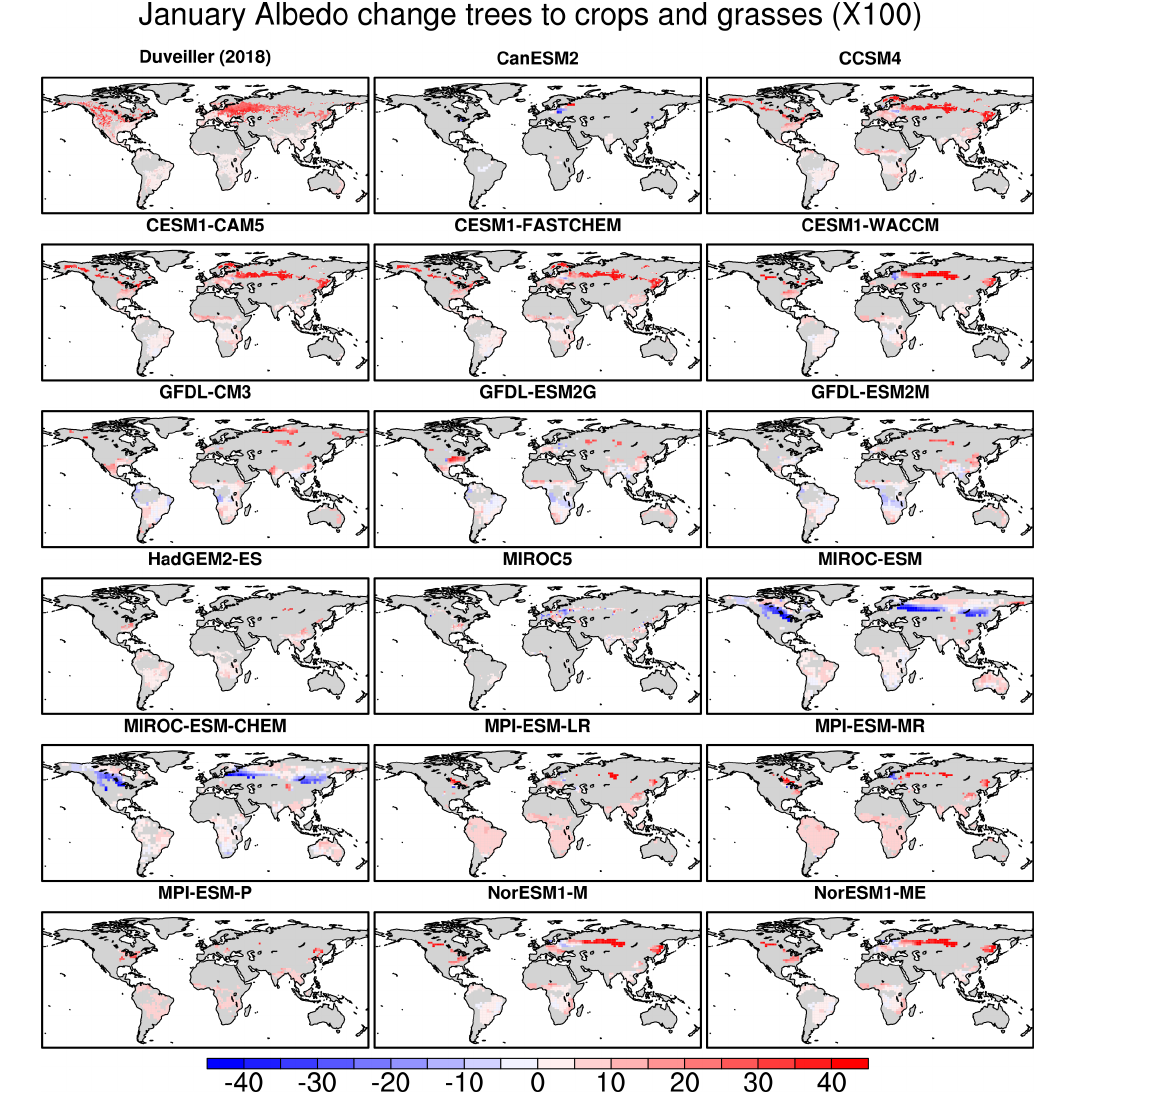
Figure 11. Same as Fig. 10, but for January. Note that the scale is